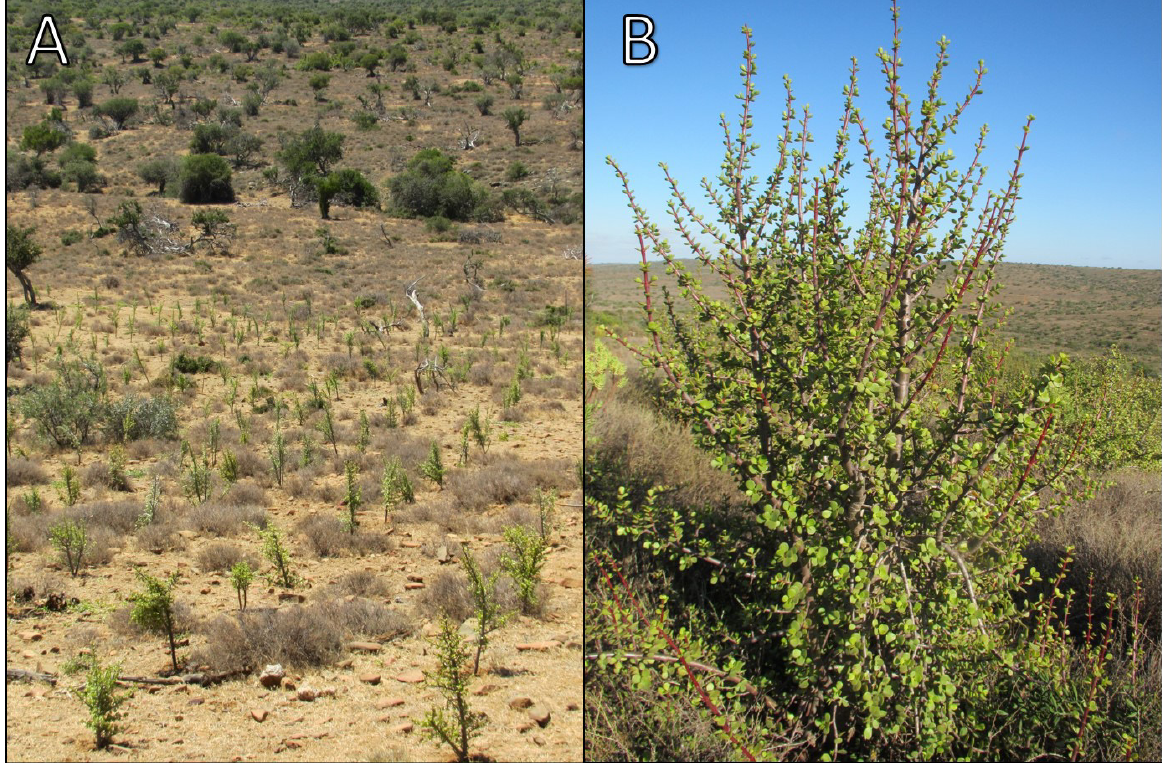
Figure 3. Spekboom cuttings planted into degraded thicket. ( A ) Newly planted cuttings; ( B ) A well-established cutting that has grown for several years subsequent to